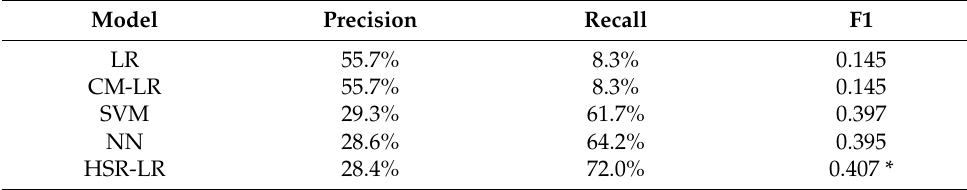
Table 6. Results on JM1.